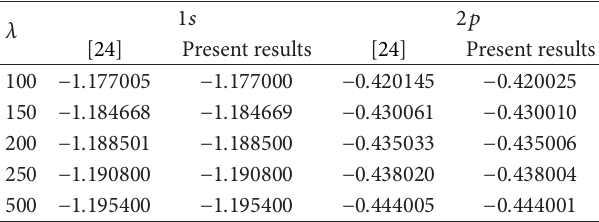
Table 5: When 𝑏 = 0.1 , 𝑐 = 1 , comparison of 1𝑠 and 2𝑝 energy eigenvalues obtained in the present study with results of [24] for different 𝜆 screening parameters in Rydberg